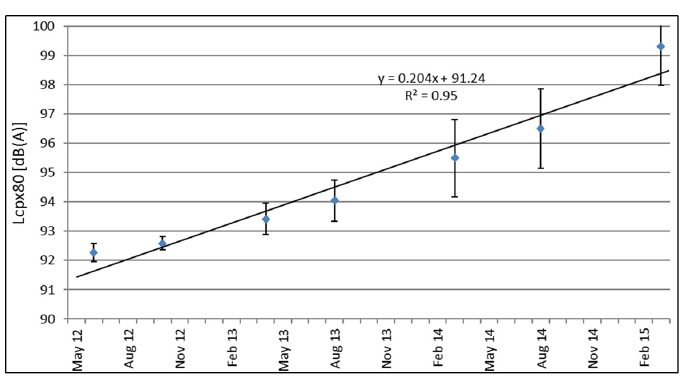
Figure 8. Increase over time based on CPX results (P1 tire) for Test Section 5 (DPAC).